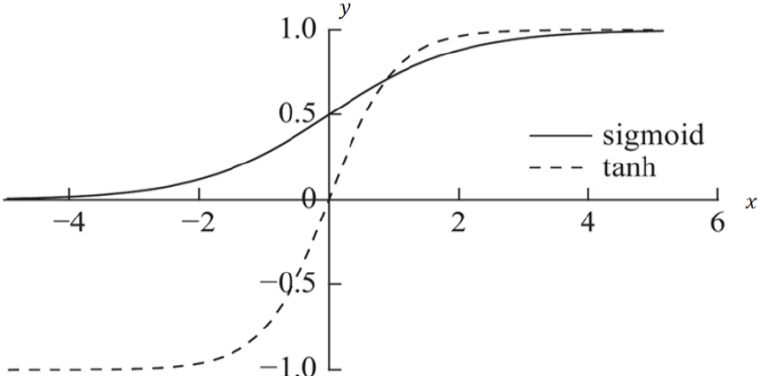
Figure 8. The curves of Sigmoid function and tanh.